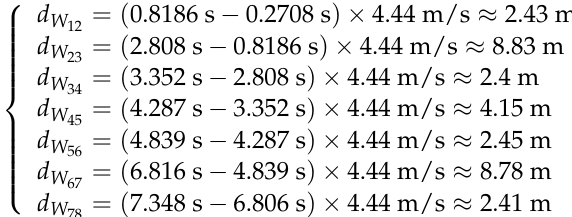
Figure 6. Raw vibration response of measuring point 1 under preseted 16 km/h excitation.